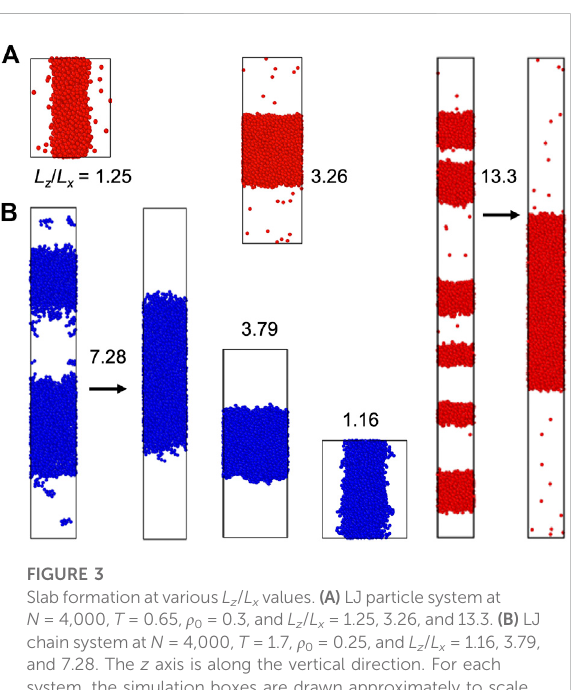
FIGURE 3 Slabformationatvarious L z / L x values. (A) LJparticlesystemat N = 4,000, T = 0.65, ρ L z / L x = 1.25, 3.26, and13.3. (B) LJ 0 =0.3,and chain system at N = 4,000, T = 1.7, ρ 0 = 0.25, and L z / L x = 1.16, 3.79, and 7.28. The z axis is along the vertical direction. For each system, the simulation boxes are drawn approximately to scale. Arrows indicate the fusion of multiple slabs into a single slab.